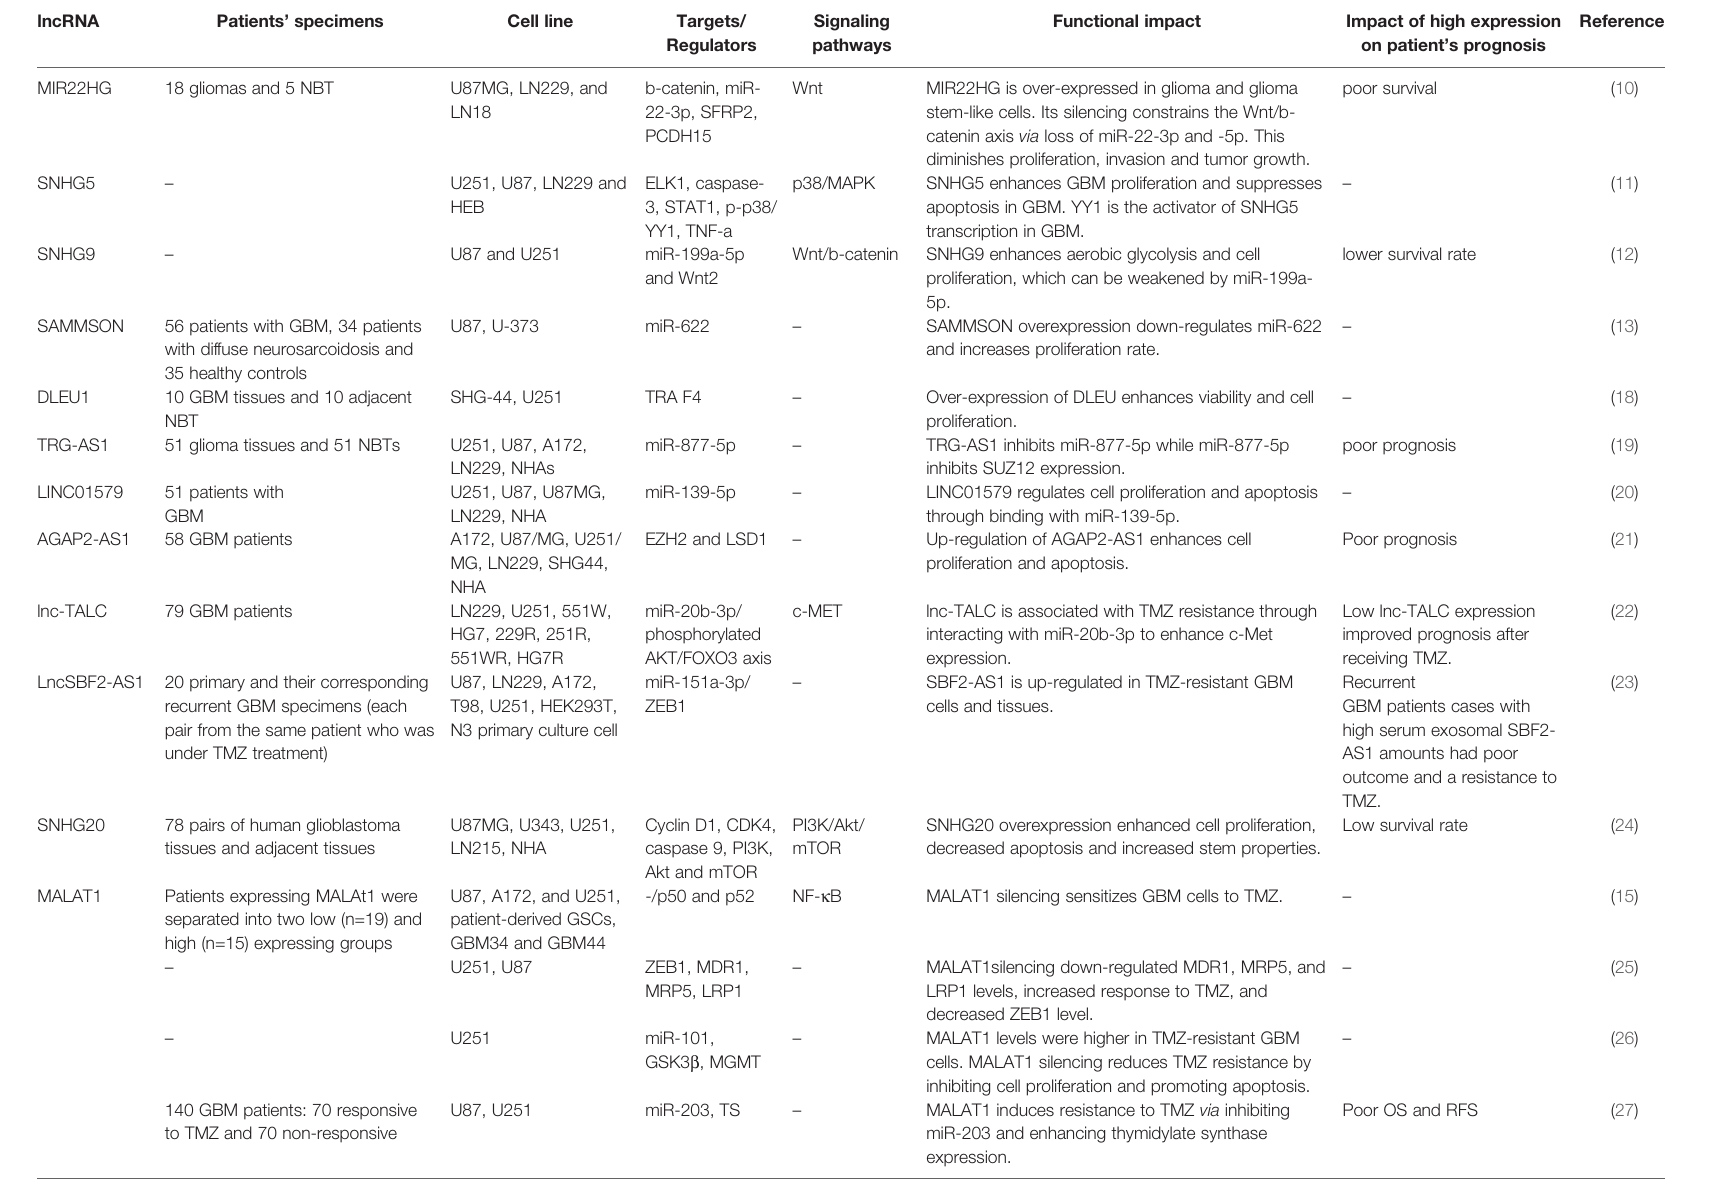
TABLE 1 | List of over-expressed lncRNAs in